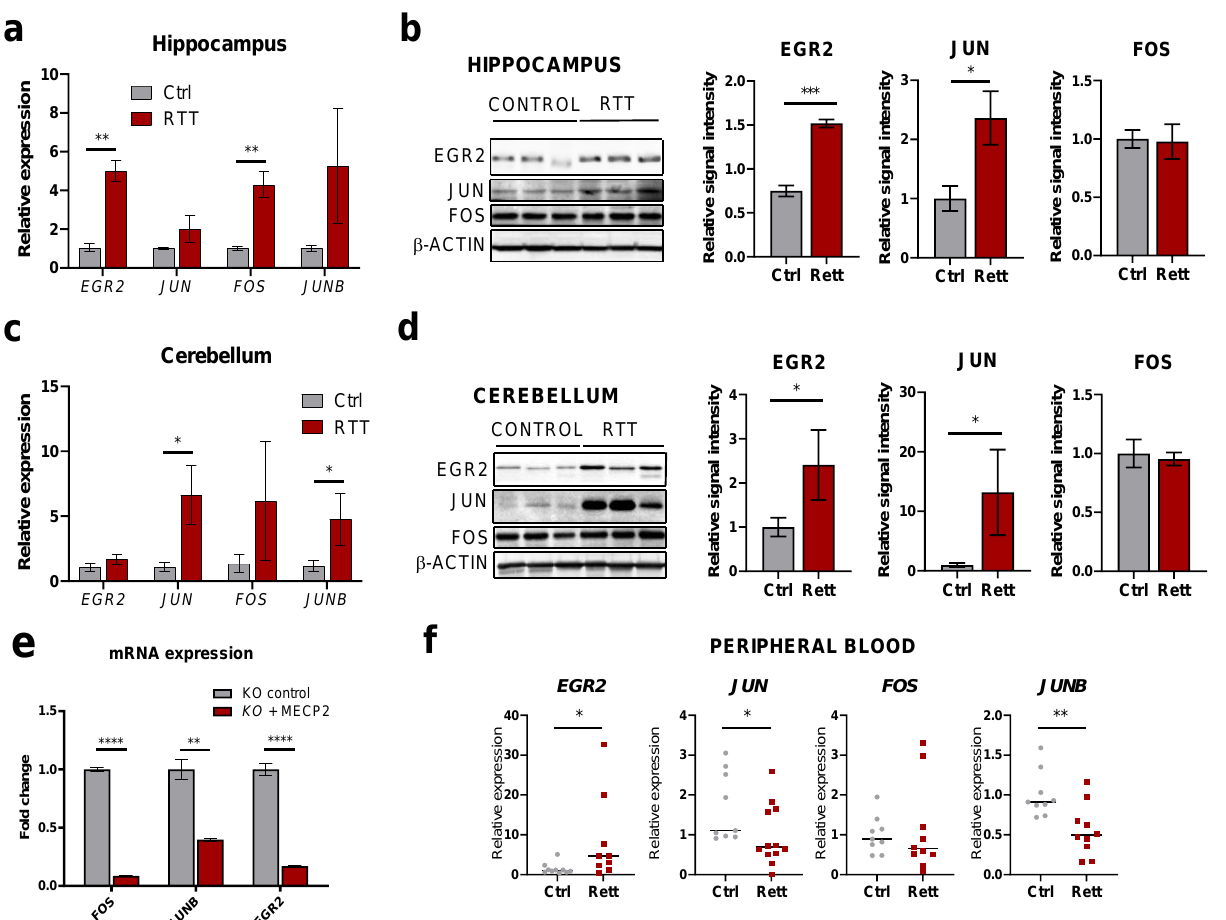
Figure 5. IEGs expression in human RTT patients and cellular models. ( a , c ) RT-qPCR analysis of EGR2 , JUN , FOS and JUNB transcript levels in the hippocampus ( a ) or cerebellum ( c ) of post-mortem RTT patients or healthy control samples ( n = 3 subjects per condition, graphs represent means ± SEM, * p < 0.05, ** p < 0.01 in Student’s t -tests). ( b , d ) Western blot analysis of EGR2, JUN and FOS protein levels in the hippocampus ( b ) or the cerebellum ( d ) of post-mortem RTT patients or healthy control samples. Graphs on the right indicate quantitation of band intensity (mean ± SEM, * p < 0.05, *** p < 0.001 in Student’s t -tests) of the three biological replicates. ( e ) RT-qPCR analysis of FOS , JUNB and EGR2 expression upon overexpression of MeCP2 in a human neural progenitor model ( n = 3 biological replicates, graphs represent means ± SEM, ** p < 0.01, **** p < 0.0001, in Student’s t -tests). ( f ) RT-qPCR analysis of EGR2 , JUN , FOS and JUNB transcript levels in the peripheral blood of RTT patients or healthy control samples ( n ≥ 10 biological replicates, graphs represent means ± SEM, * p < 0.05 and ** p < 0.01 in Student’s t -tests).